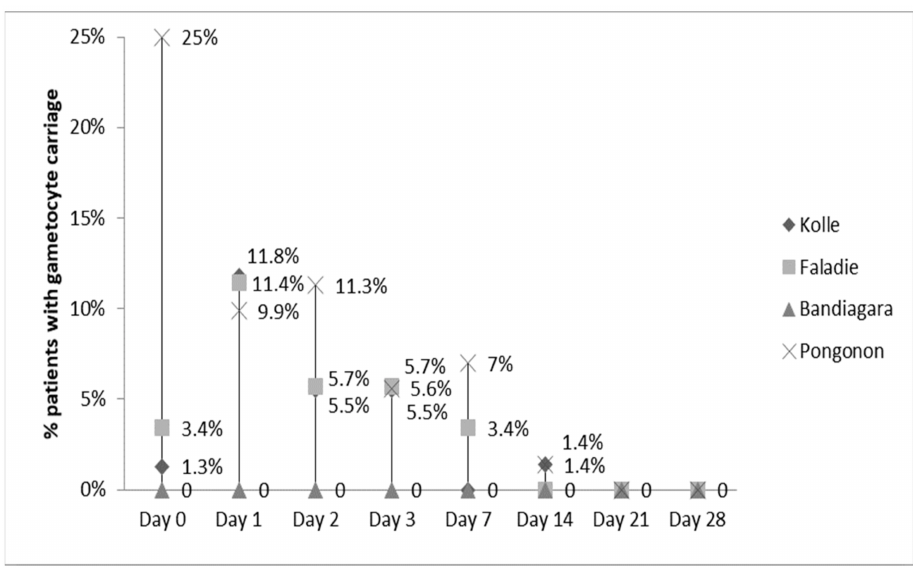
Figure 3. Gametocytemia clearance.